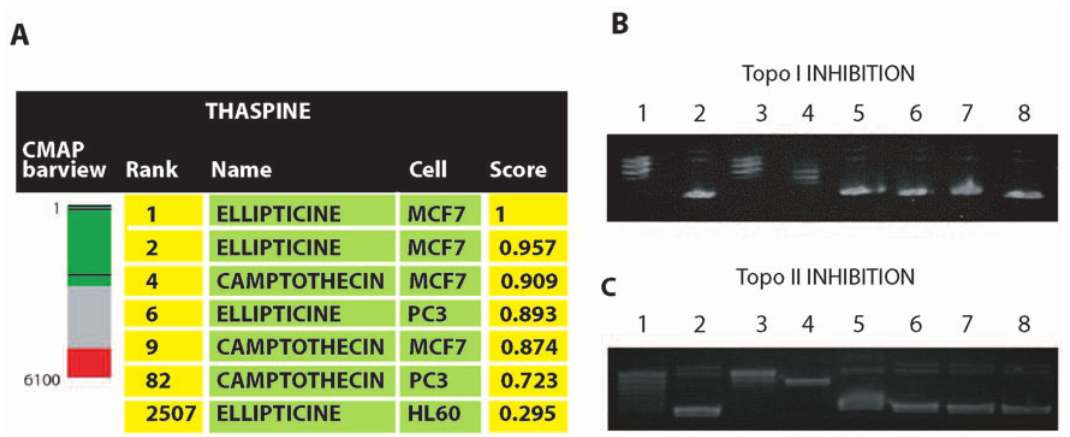
Figure 4. Thaspine is a topoisomerase inhibitor. (A) Connectivity Map (CMAP) results after treatment with thaspine. The bar view is constructed from 6100 horizontal lines, each representing a single treatment and ordered according to their corresponding enrichment to the query signatures generated after thaspine treatment. Black horizontal lines in the barview represent the individual instances for ellipticine and camptothecin when the thaspine expression signature was used as query signature. Score according to the CMAP database; (B) inhibition of topoisomerase I activity: 1 : plasmid + 5U topoisomerase I; 2 : plasmid; 3 : plasmid + 5U topoisomerase I + DMSO (1 m m); 4 . Marker for nicked plasmid; 5 : plasmid + 5U topoisomerase I + 50 m M thaspine; 6 : plasmid + 5U topoisomerase I + 25 m M thaspine; 7 : plasmid + 5U topoisomerase I + 10 m M thaspine; 8 : plasmid + DMSO (1 m m). Topoisomerase I primarily induced nicked plasmid DNA, note the inhibition by thaspine. (C) inhibition of topoisomerase II activity: 1 : plasmid + 15U topoisomerase II; 2 : plasmid; 3 : plasmid + 15U topoisomerase II + DMSO (1 m m); 4 . Marker for nicked plasmid; 5 : plasmid + 15U topoisomerase II + 50 m M thaspine; 6 : plasmid + 15U topoisomerase II + 25 m M thaspine; 7 : plasmid + 15U topoisomerase II + 10 m M thaspine; 8 : plasmid + DMSO (1 m m). Topoisomerase II primarily induced nicked plasmid DNA, note the inhibition by thaspine.